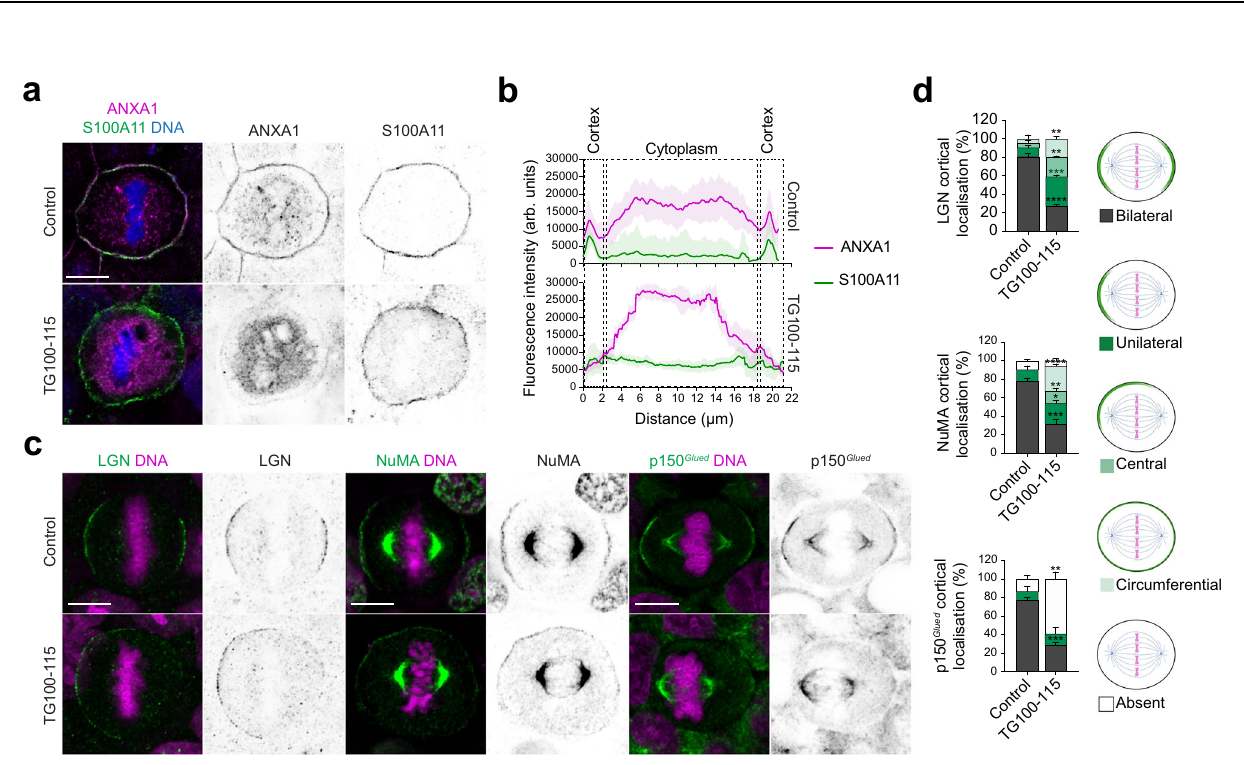
Fig. 2 | ANXA1 is required for correct localisation of the LGN-NuMA-Dynein- Dynactin complex atthe cell cortex during mitosis. a Left: time-lapse images of representative MCF-10A cells stably expressing GFP-LGN (green), treated with si- Controlorsi-ANXA1#1.DNAisstainedwithHoechst33342(magenta)30minbefore imaging. Right: illustration showing the observed cortical localisation of GFP-LGN. b WesternblottingofextractsfromsiRNA-transfectedcells. c Percentageofcortical localisation of GFP-LGN in siRNA-transfected cells (si-Control: n =53 cells; si- ANXA1#1: n =42 cells). Two-sided t -test, bilateral: **** P <0.000001; unilateral: * P =0.0475; central: **** P =0.000004; circumferential: * P =0.0233. d Confocal images of representative si-Control-, si-ANXA1#1- and si-ANXA1#2-transfected metaphase cells expressing or not ANXA1-mCherry and stained for LGN, NuMA or p150 Glued (green)andcounterstainedwithDAPI(DNA,magenta). e Westernblotting of extracts from siRNA-transfected cells expressing or not ANXA1-mCherry. f Percentageof corticallocalisationof LGN,NuMAorp150 Glued insiRNA-transfected